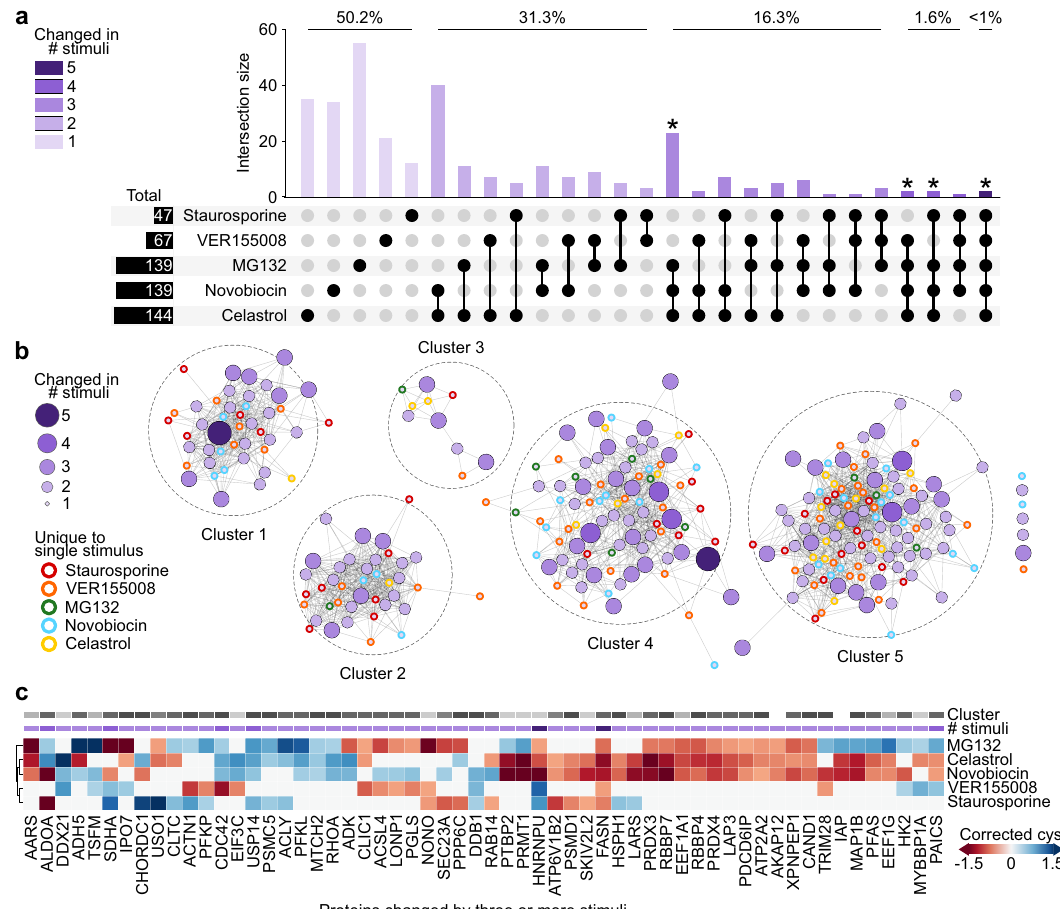
Fig. 3 Conformational remodeling is poorly conserved in individual proteins in response to diverse stimuli. Proteins which were quanti fi ed in each of the fi ve individual datasets, and which changed reactivity in response to at least one stimulus, were collected as the comparison protein set. a UpSet intersection plot of conformational change among comparison proteins. Individual proteins appear once within the column bar graph, according to the combination of stimuli in response to which they were seen to change conformation (irrespective of reactivity direction). The proportion of proteins associated with a change in 5, 4, 3, 2, or 1 conditions are indicated above the corresponding bars. b Protein interaction network for comparison proteins. Protein nodes are colored and sized according to their degree of commonality across stimuli in a , and for fi rst-degree proteins, the corresponding stimulus is indicated by border color. Nodes were arranged organically following clustering with the Girvan – Newman community detection algorithm, and edges (lines) connect proteins with known interactions within each cluster (STRINGdb v 11.0, medium con fi dence score >0.4). c Heatmap for maximum change in cys reactivity among comparison proteins with degree >3 from a . Both degree (# stimuli) and cluster number are indicated for each protein above the heatmap, and the dendrogram shows the result of agglomerative clustering of the fi ltered comparison proteins in the stimulus dimension. Source data are provided as a Source Data fi residues contributed by PSMB5, PSMB6, and PSMB7 (proteasome subunits beta type-5, -6, and -7, possessing chymotrypsin-like, caspase-like, and trypsin-like activity, respectively), degrade sub- strate. Subunits located within the core 20 S complex saw conserved protection in response to MG132, VER155008 and novobiocin (Fig. 4e – g). The observed protection is consistent with an increase in the occupation of the catalytic chamber, which we anticipate as a response to the accumulation of unfolded proteins. The TPE-MI reactivity of the regulatory particle subunits was heterogeneous across stimuli. Member subunits of the 19 S regulatory particle (PSMC5, PSMD6 and PSMD13) were protected in the presence of MG132 and VER155008 (Fig. 4e, f). The regulatory particles associate with the termini of the barrel- shaped core complex, where they recognize ubiquitylated client proteins and assist in their unfolding and translocation into the β - ringed catalytic chamber. The increased protection in the presence of MG132 and VER155008 may re fl ect increased